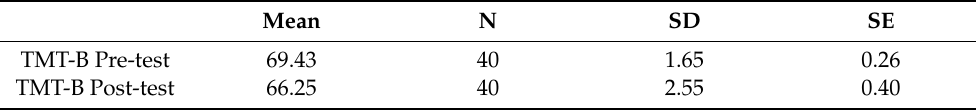
Table 19. Paired sample correlations of TMT-B. N Correlation Sig. TMT-B Pre/post-test 40 0.371